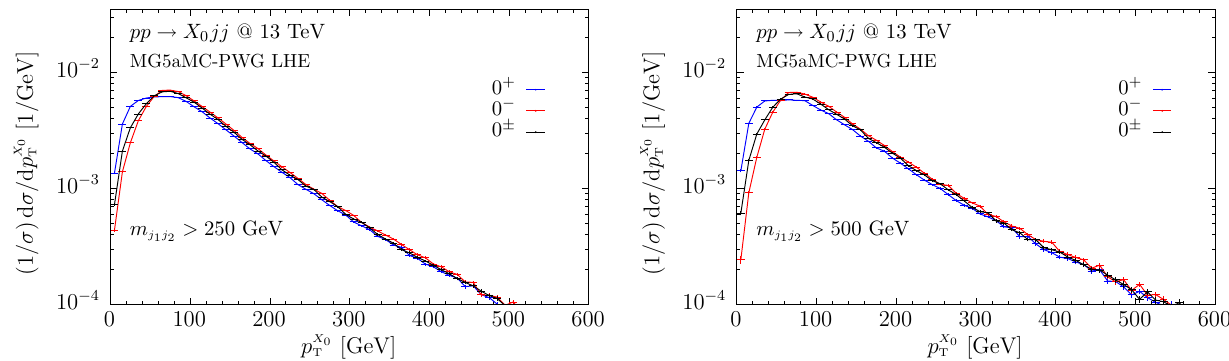
Fig. 2 Normalised differential cross section as a function of the transverse momentum of the spin-0 boson X 0 , for the three CP scenarios. On the left panel, a cut of 250 GeV is imposed on the dijet mass, while on the right panel a cut of 500 GeV is applied. The colour code is the same as in Fig. 1